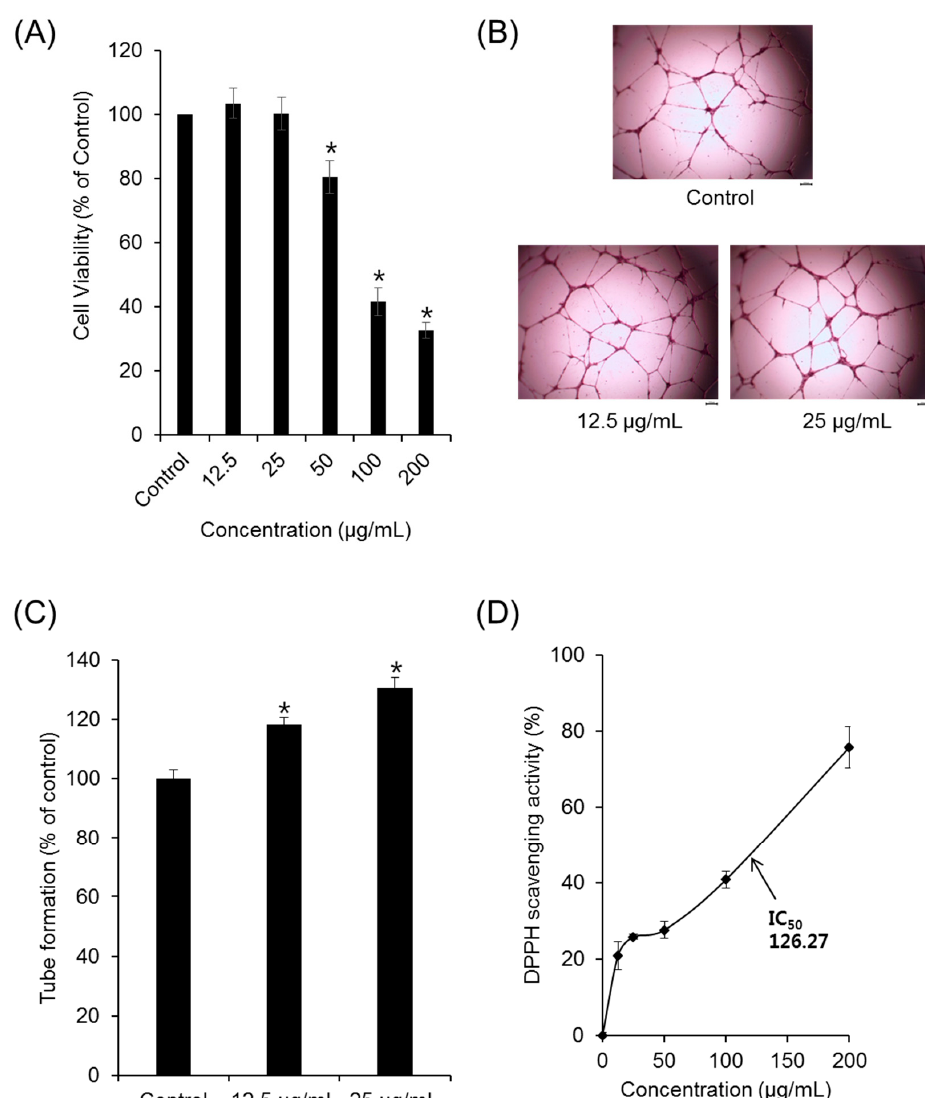
Figure 1. Effects of Lithospermi Radix (LR) extract on angiogenesis and oxidative stress. ( A ) The effects of LR extract on human umbilical vein endothelial cell (HUVEC) proliferation. ( B ) Representative image showing tube formation. Scale bar = 200 µm. ( C ) The effects of LR extract on tube formation in HUVECs on Matrigel. ( D ) The concentration-dependent antioxidant activity of LR extract using a DPPH radical assay. Data are expressed as means ± SEM. Similar results were obtained in three independent experiments; * p < 0.05 compared to the control value.